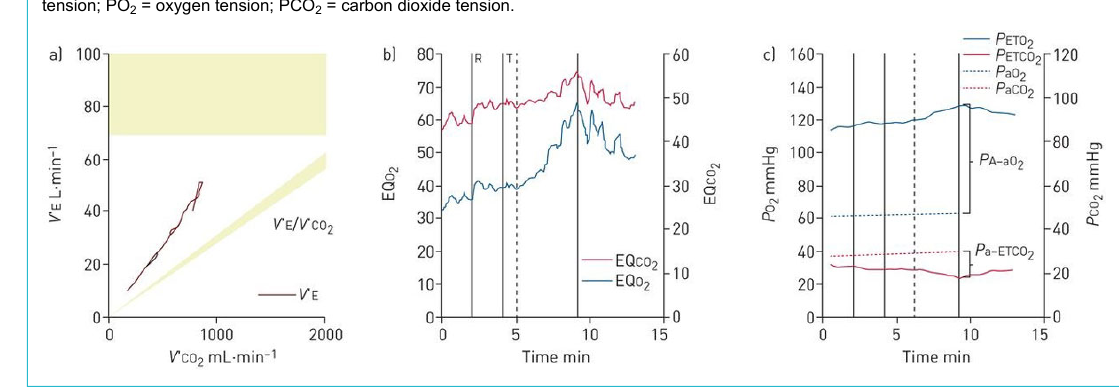
Figure 5: Cardiopulmonary exercise testing of a patient with chronic thromboembolic pulmonary hypertension showing fields 4, 6 and 9 of the Wasserman panel. (a) Elevated slope of minute ventilation (V′E) / carbon dioxide output (V′CO 2 ) ratio showing hyperventilation (field 4); (b) el- evated ventilator equivalents for oxygen (EQO 2 ) and carbon dioxide (EQCO 2 ) showing ineffective ventilation (field 6); (c) low and decreasing end-tidal carbon dioxide tension (PETCO 2 ), elevated alveolar-arterial oxygen tension gradient (PA-aO 2 ) and elevated arterial end-tidal carbon dioxide gradient (Pa-ETCO 2 ) (field 9). Reproduced with permission of the European Respiratory Society. Eur Respir Rev. 2017;26(143):160108 [43]. © ERS 2017. PETO 2 = end-tidal oxygen tension; PaO 2 = arterial oxygen tension; PaCO 2 = arterial carbon dioxide tension; PO 2 = oxygen tension; PCO 2 = carbon dioxide